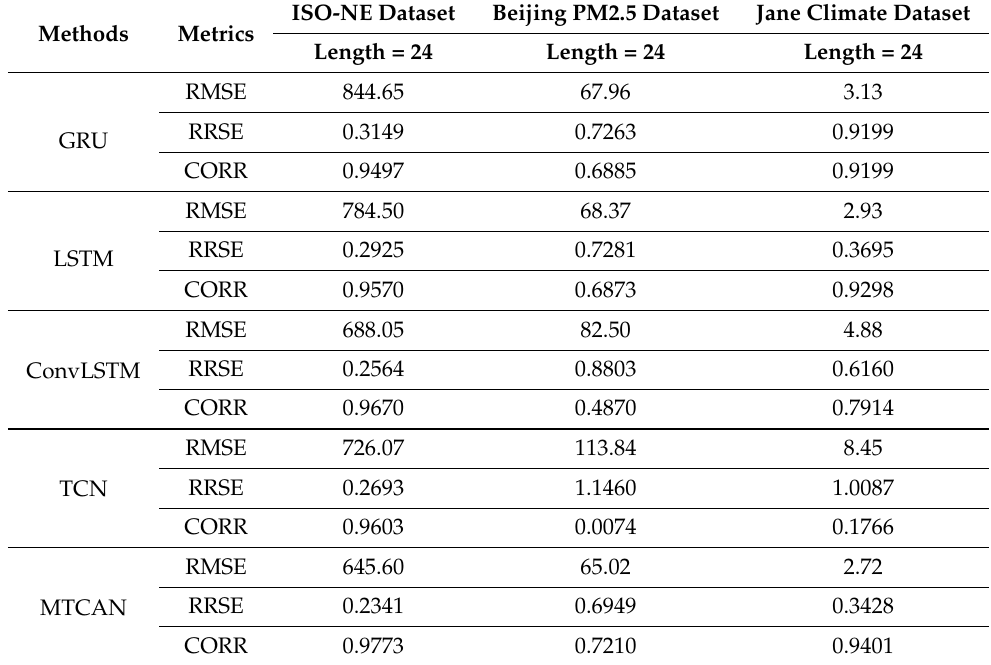
Table 2. Results summary (in RMSE, RRSE, and CORR) of all methods with three datasets: each row has the results of a specific method in a particular metric.